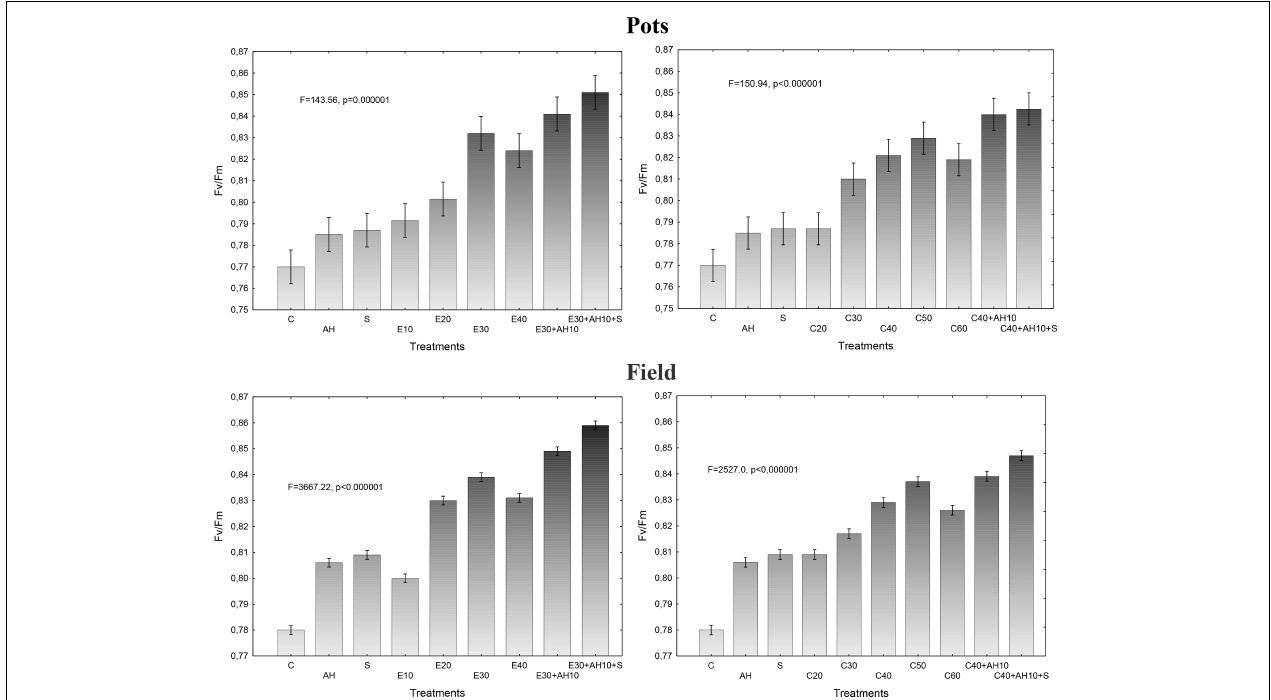
FIGURE 1 | Maximum PSII efficiency in sorghum leaves cultivated in pots and field and fertilized with liquid waste from a biomass biodigestion to methane, non-centrifuged (E 10–40 m 3 ha − 1 ) and centrifuged (C 20–60 m 3 ha − 1 ), Apol-humus (AH; 10 L ha − 1 ) and Stymjod (S; 5 L ha − 1 ).